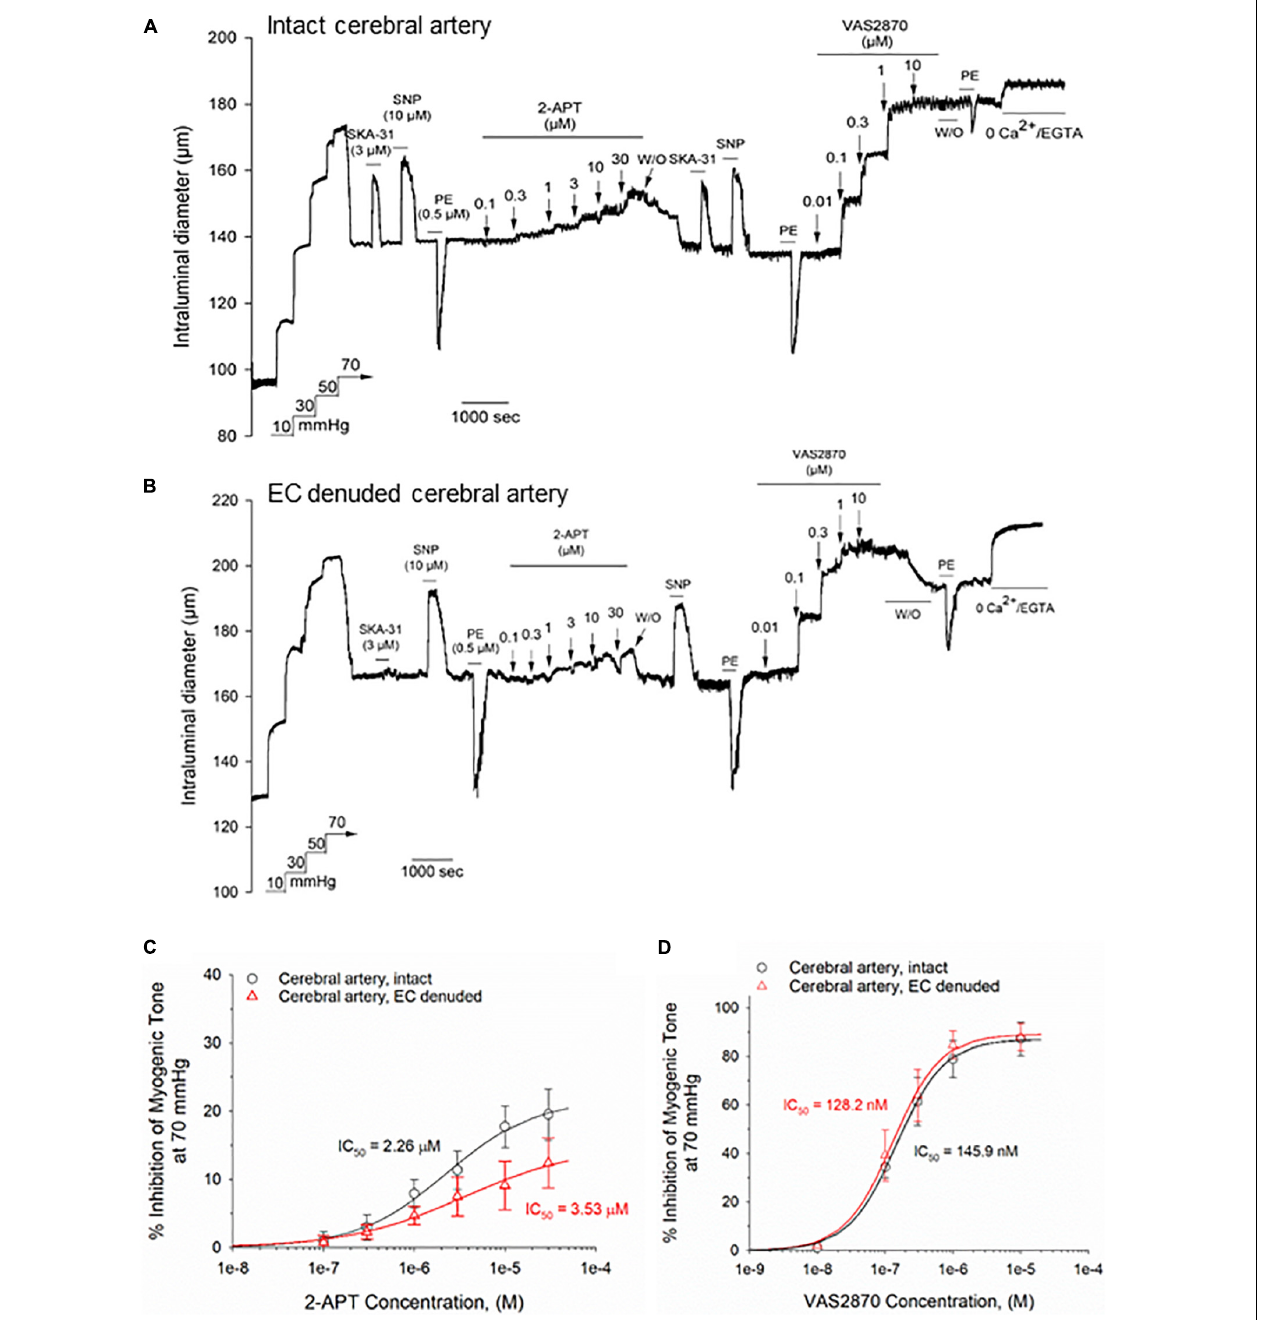
FIGURE 3 | The NOX inhibitors 2-APT and VAS2870 inhibit developed myogenic tone in Sprague–Dawley rat cerebral arteries. Panel (A) shows a representative tracing of a myogenically contracted middle cerebral artery with intact endothelium, and reversible responses of the artery to the endothelium-dependent vasodilator SKA-31 (3 µ M), the smooth muscle vasorelaxant sodium nitroprusside (SNP, 10 µ M) and smooth muscle contractile agent phenylephrine (PE, 0.5 µ M). Treatment of the artery with increasing concentrations of 2-APT evoked vasodilatory responses that reversed upon washout of 2-APT from the bath. VAS2870 (0.01–10 µ M) was then perfused through the bath in a sequential manner, followed by washout. At the end of the protocol, PE stimulation was repeated, followed by perfusion of the bath with a physiological saline solution containing 0 added CaCl 2 + 2 mM EGTA to evoke maximal arterial diameter. The horizontal lines above and below the tracing indicate the presence of the indicated stimulus or treatment. The representative tracing in panel (B) illustrates the effects of a very similar treatment protocol performed in an endothelial cell (EC)-denuded cerebral artery. The plots in panels (C,D) quantify the concentration-dependent inhibition of basal myogenic tone by 2-APT and VAS2870, respectively, for intact ( n = 4) and EC-denuded cerebral arteries ( n = 4–5). The indicated IC 50 values for inhibition of myogenic tone and the non-linear regression fits to the plotted data symbols were calculated using a Hill equation (see section “Materials and Methods”). Data are presented as means ±